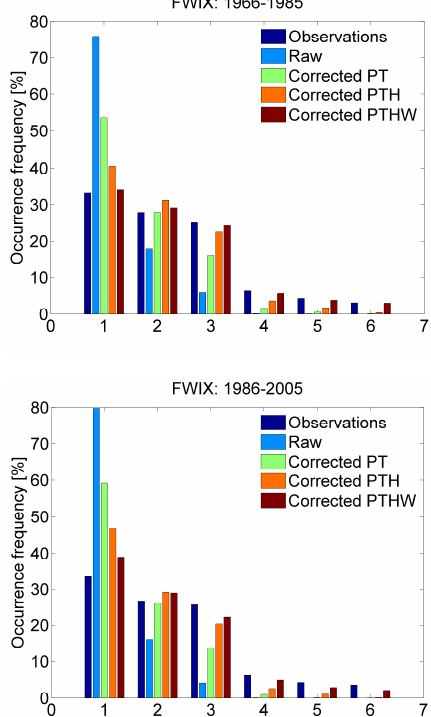
Figure 8. The occurrence frequency of fire danger classes (i.e. FWIX) at the Edsbyn station (see Fig. 1) calculated from ob- servation, raw climate model output, RCA3-E5r3-A1B, and after correcting meteorological